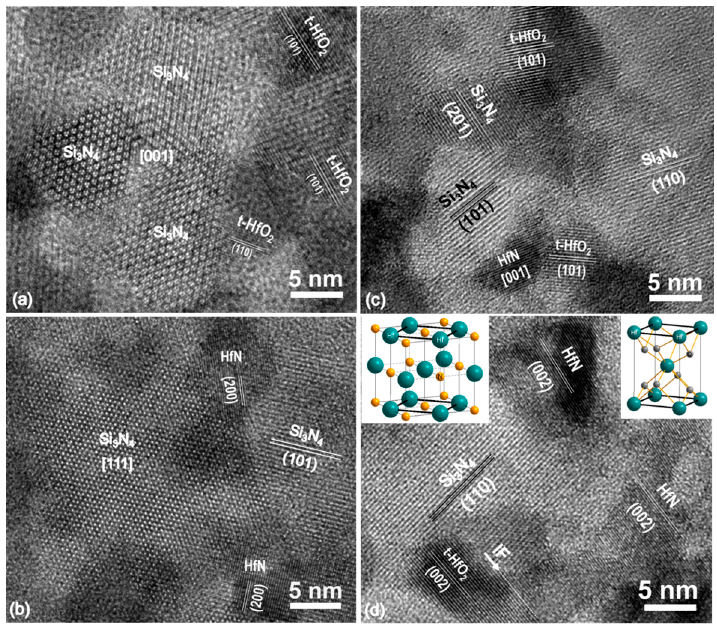
Figure 11. HRXTEM images taken from ( a ) the transition layer and ( b ) bottom, ( c ) top, and ( d ) middle section of the recrystallized layer in the annealed Hf 7 B 10 Si 32 C 2 N 44 film.